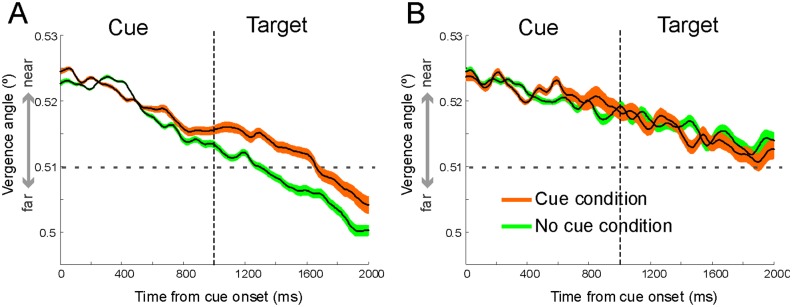
Average size of angle of eye vergence.Average (across all subjects) size of angle of vergence in the informative cue and uninformative cue conditions over time for the control group (A) and the ADHD group (B). Shaded areas represent ±1 times SEM around the mean. Dotted vertical lines indicate the time of target (face emotion) presentation. Horizontal dashed line indicates vergence angle belonging to the estimated screen distance.